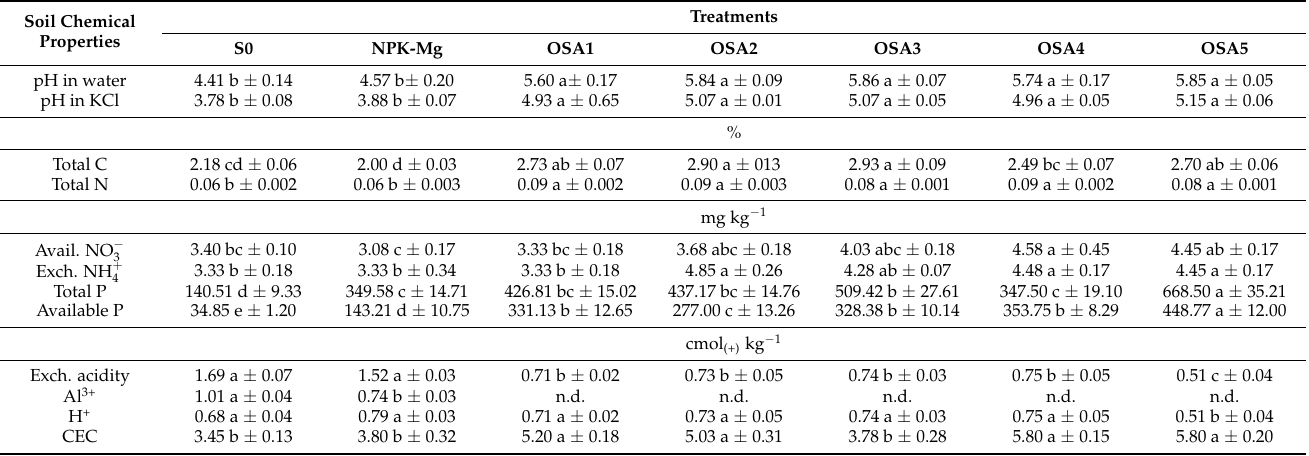
Table 6. Effects of organic soil amendments on chemical properties of Nyalau series soil after the second cropping cycle of rice cultivation.